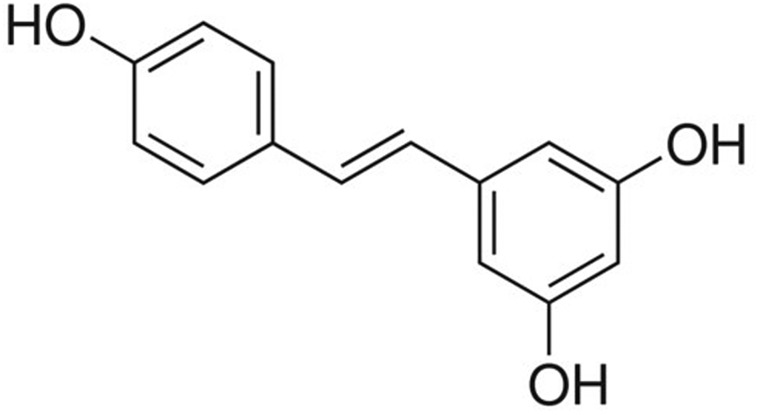
Structure of trans-resveratrol (trans-3,5,4′-trihydroxystilbene, C14H12O3, molecular weight: 228.24 g/mol). The stilbene core consists of a trans-ethane double bond substituted with a phenol group on both carbon atoms of the double bond. It is practically insoluble in non-organic solvents. The three -OH groups of trans-resveratrol confer an estimated water solubility of 0.03 g/ml which makes impossible the use of aqueous resveratrol solution in our study.